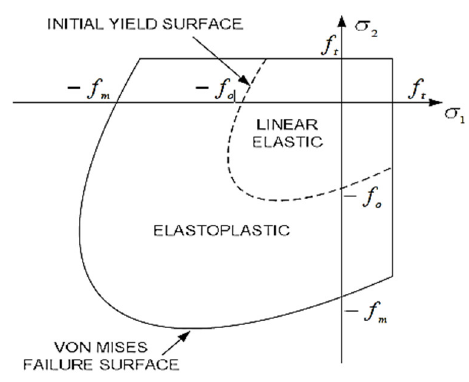
Figure 4. Yield and failure surface [36].